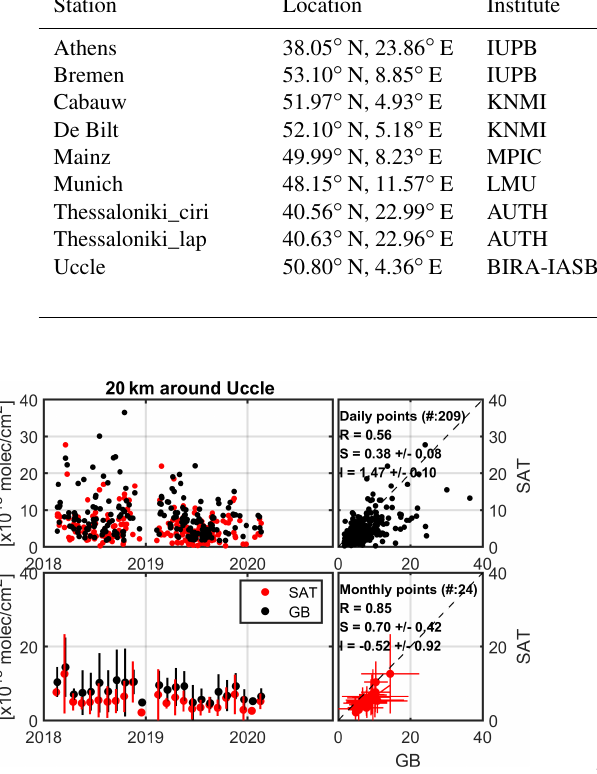
Figure 21. Daily and monthly mean time series and scatter plot of TROPOMI (SAT) and MAX-DOAS (GB) tropospheric NO 2 columns (closest valid pixel within 20km of Uccle). Results are shown for the improved satellite retrieval algorithm.